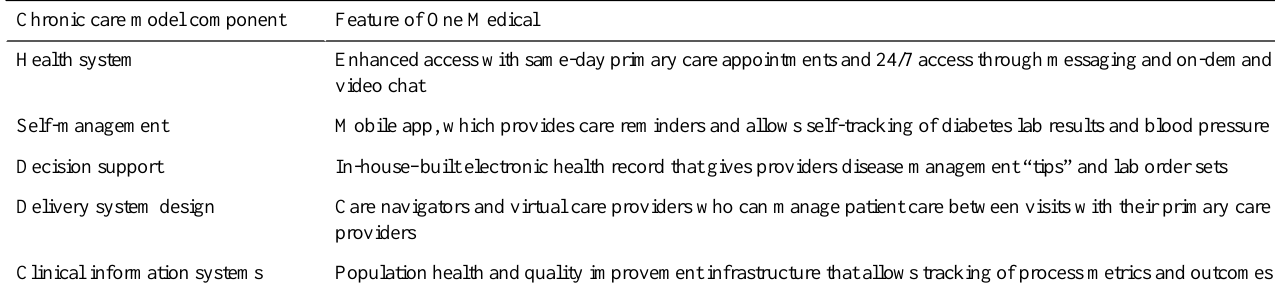
Table 1. Chronic care model components of the One Medical model. Feature of One MedicalChronic care model component Enhanced access with same-day primary care appointments and 24/7 access through messaging and on-demand chatHealth video